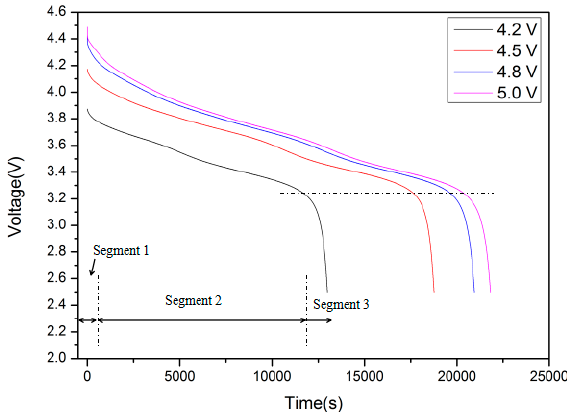
Figure 3. Discharging curves of LIBs subjected to different cut-off voltage at 2 C rate.